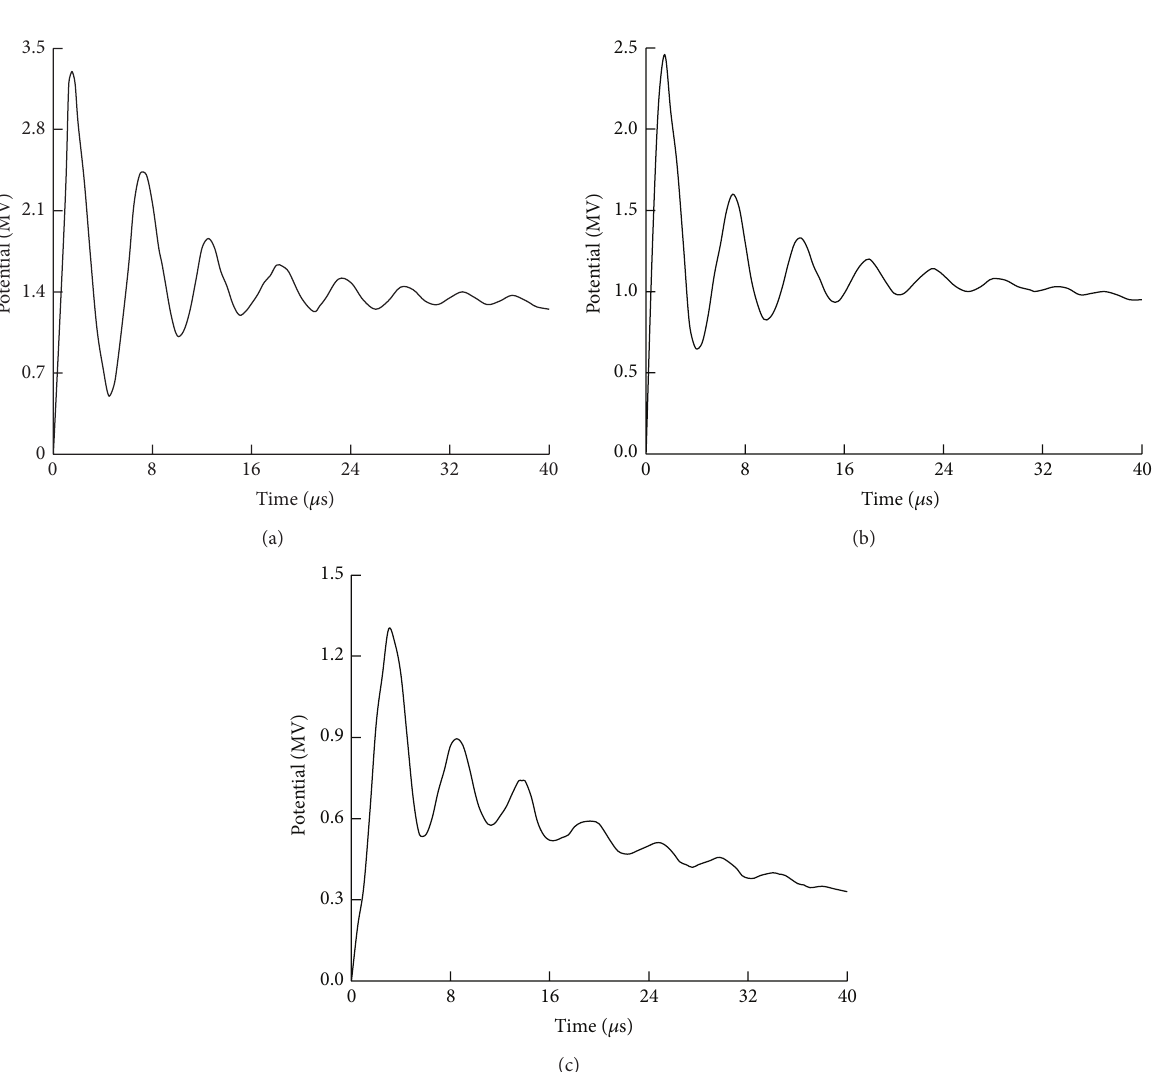
Figure 13: Transient potential waveforms. (a) At blade tip. (b) At tower top. (c) At tower